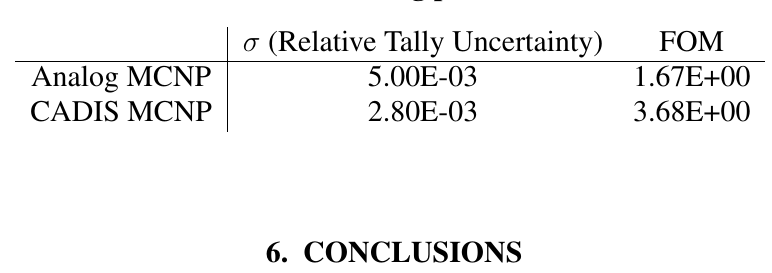
Table 2: Detector shielding problem with